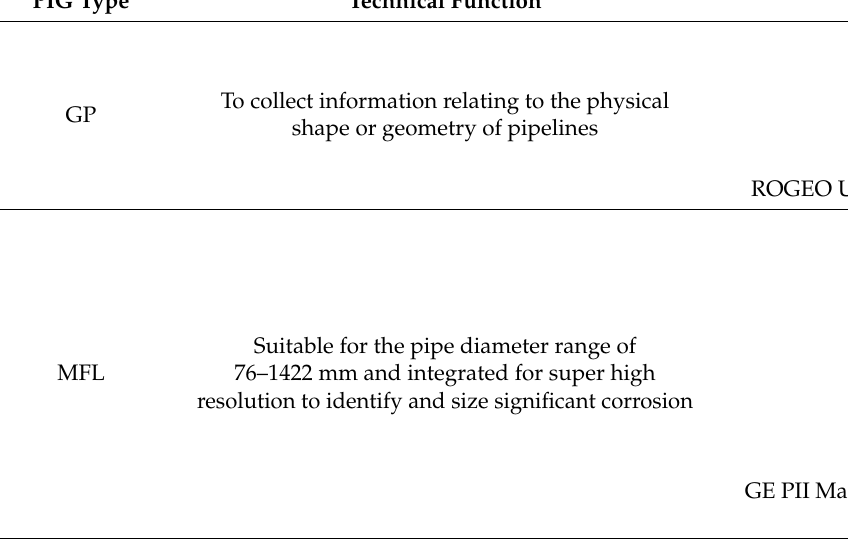
Figure 3. Magnetoelectric compound sensor detection device. (Reprinted with permission from ref. [124]. Copyright 2019 Xiaoting, G., et al). Table 4. Emerging commercial Pipeline Inspection Gauge (PIG) technologies.